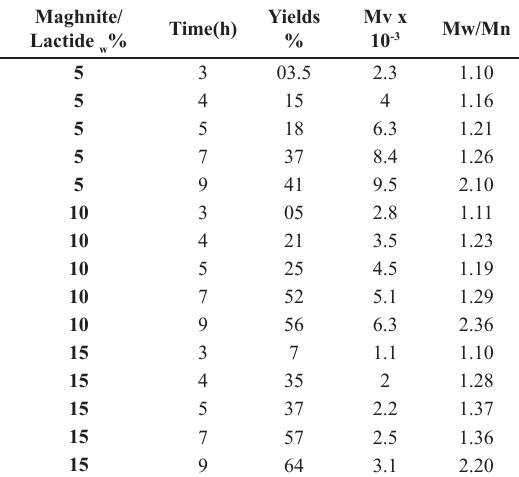
Table 2. Kinetics of D,L-lactide polymerisation catalysed by Maghnite-H + (T=100°C)